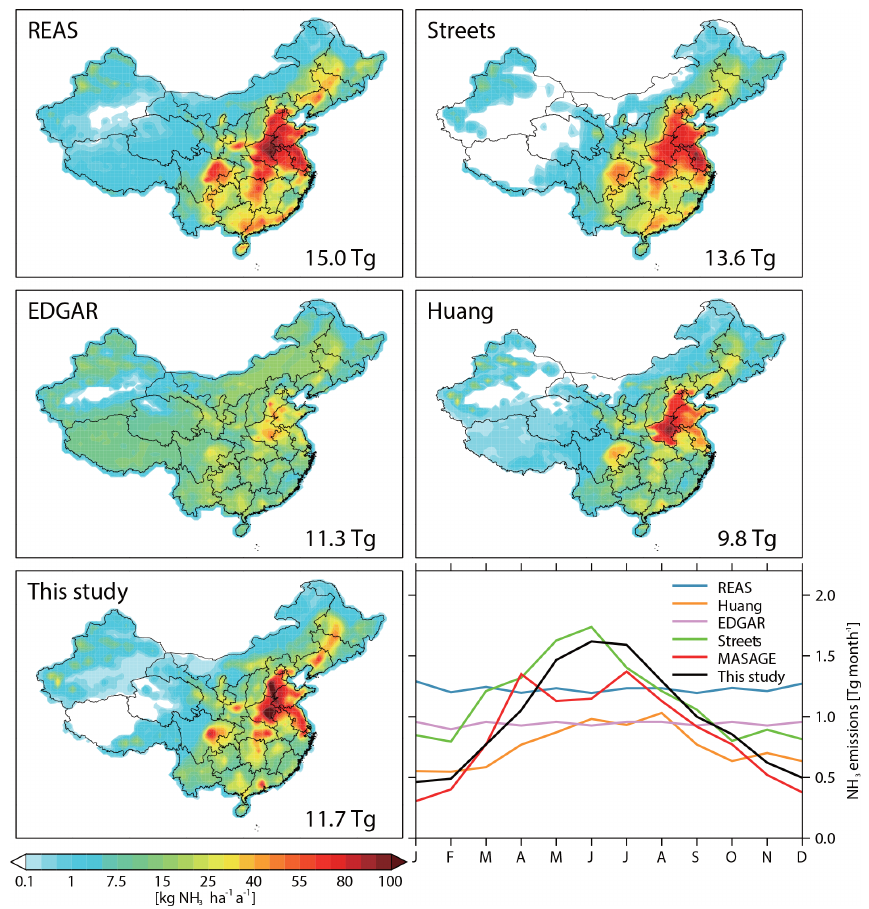
Figure 1. Spatial and seasonal variations of anthropogenic NH 3 emissions in China from different bottom-up inventories. Numbers inset are annual totals of Chinese anthropogenic NH 3 emissions. See Table 1 for references of the emission